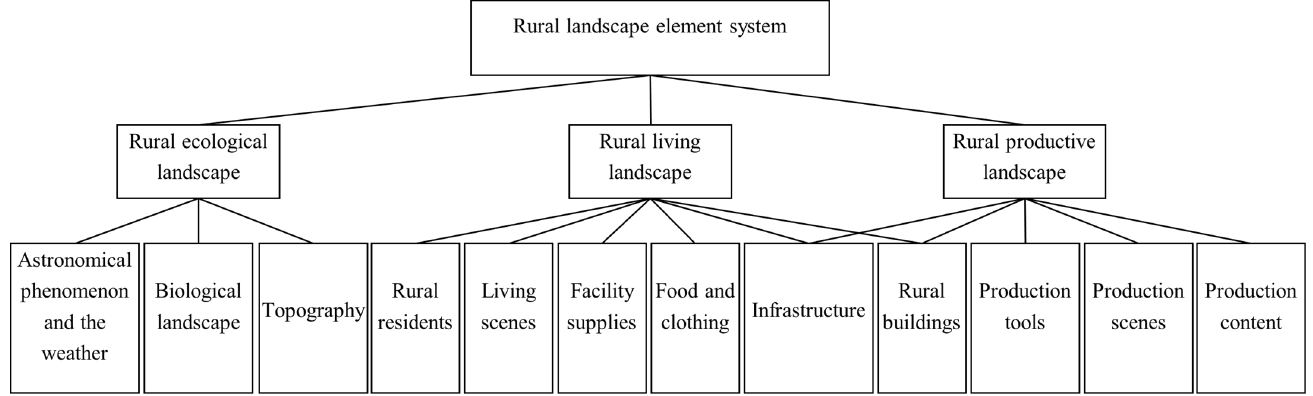
Figure 2. Analysis of the formation of the main rural landscape categories.